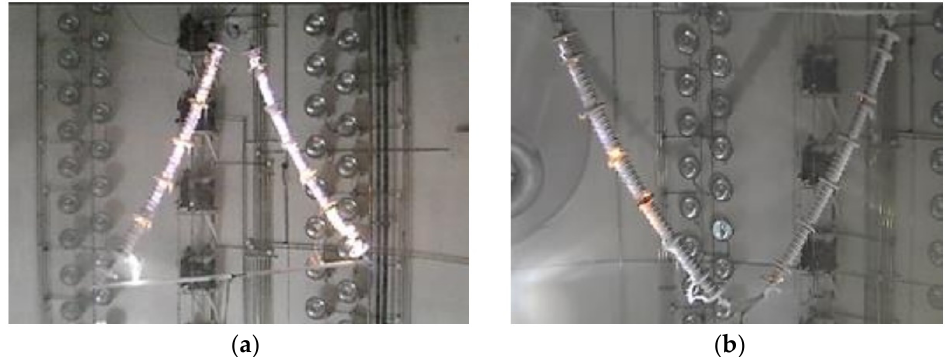
Figure 28. Flashover situation of insulator string of 60° Λ and V arrangement. ( a ) Λ shape arrange- ment. ( b ) V shape arrangement [60].